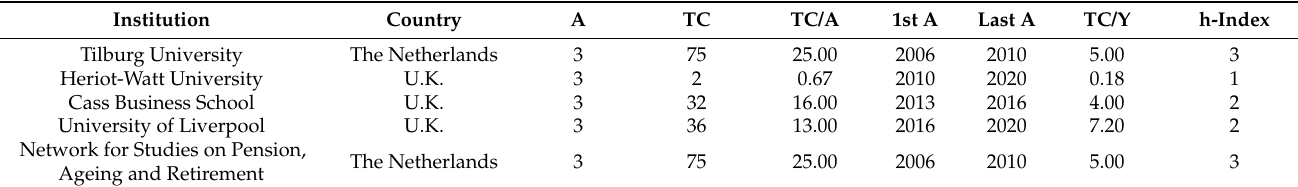
Table 16. The top 5 most productive institutions on pension research in the Mathematics area.